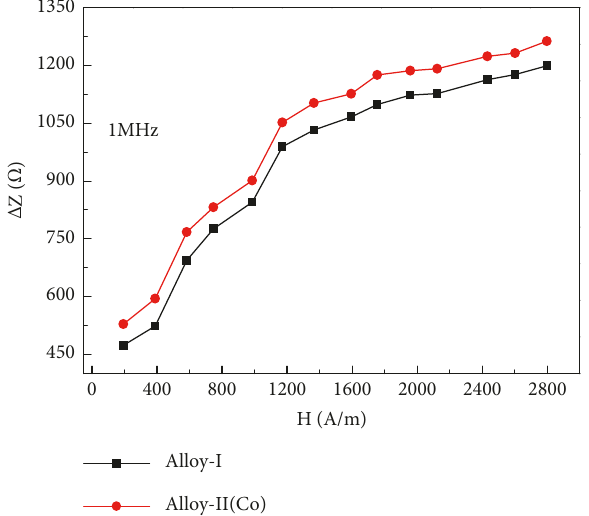
Figure 6: The magnetoimpedance effect of Alloy-I and Alloy-II(Co) amorphous/nanocrystalline strips after heat treatment at 550 ∘ C.